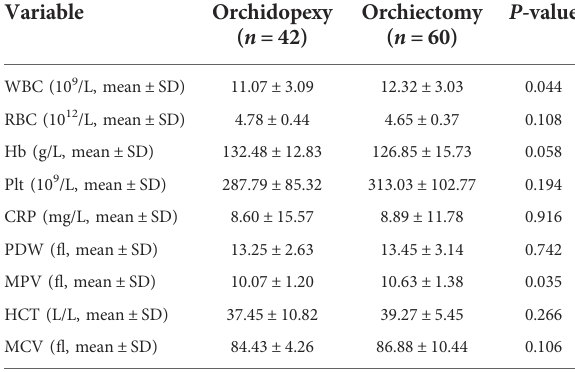
TABLE 4 Hematologic parameters of the study groups.